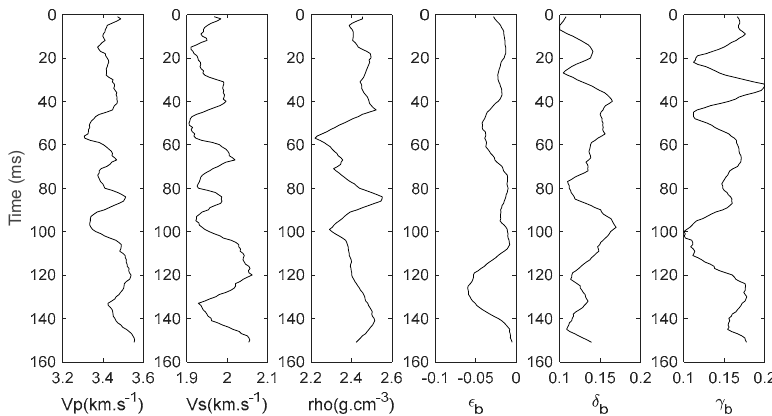
Figure 3. Interpretation results of well log and vertical seismic profiling (VSP) data (P- and S-wave velocity, density, and WA parameters).